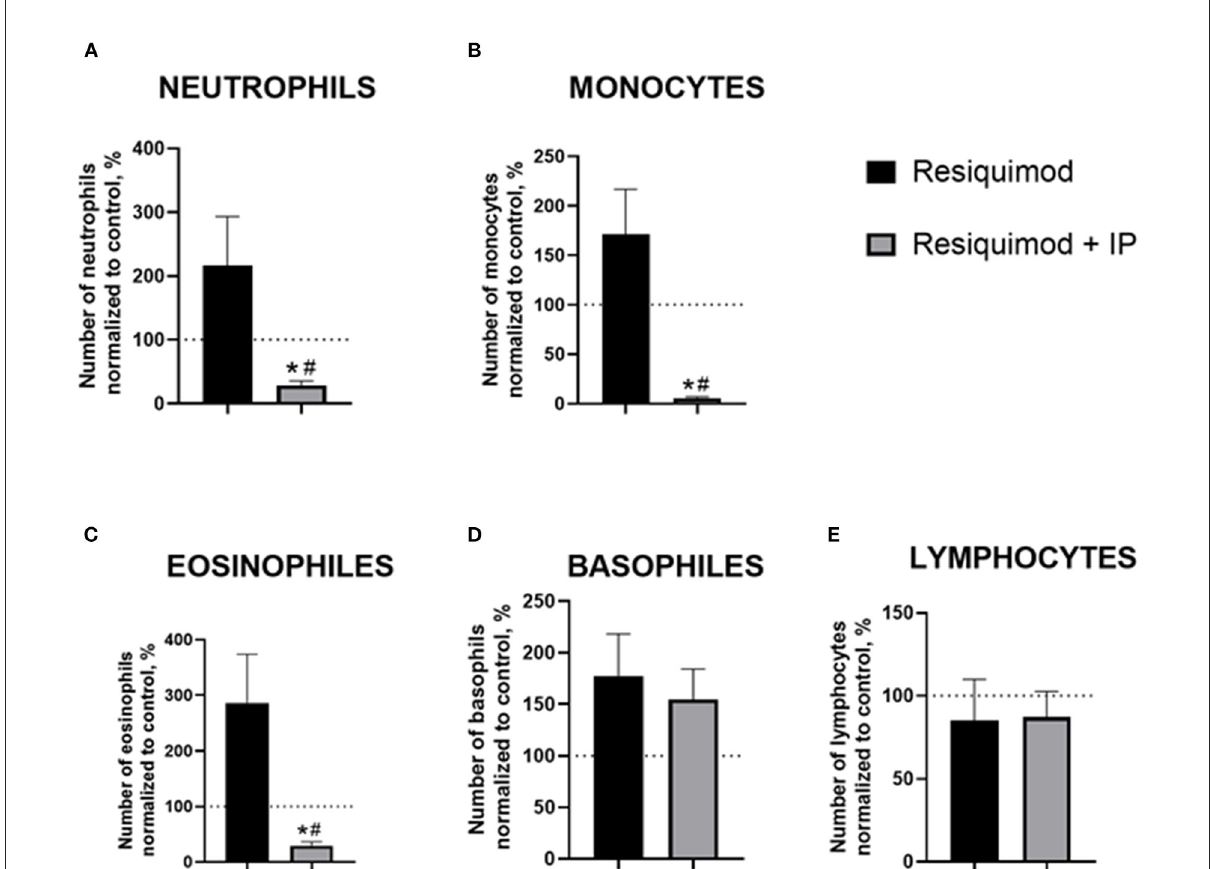
FIGURE3 Pro-inflammatory effects of resiquimod on blood formula are reduced in mice treated with the herbal IP composition. Normalized counts of (A) neutrophils, (B) monocytes, (C) eosinophils were significantly decreased in IP-treated resiquimod-stimulated mice. (D) An increase in basophil counts was similar in the two challenged groups. (E) No changes were found in the lymphocyte counts of the resiquimod-injected groups; *vs. 100% level, #vs. the challenged non-treated group (Welch’s test and t -test, see the text). Data presented as mean ±